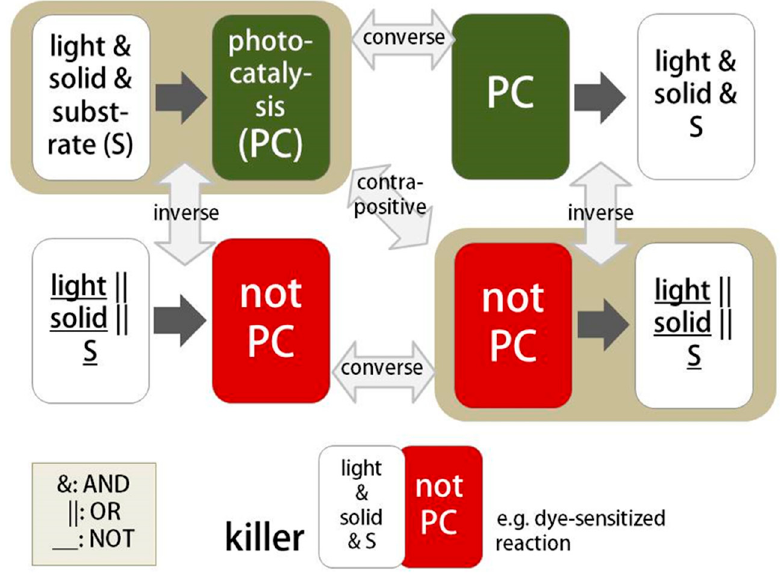
Figure 3. Propositions relating to the control experiment for proof of semiconductor photocatalysis.